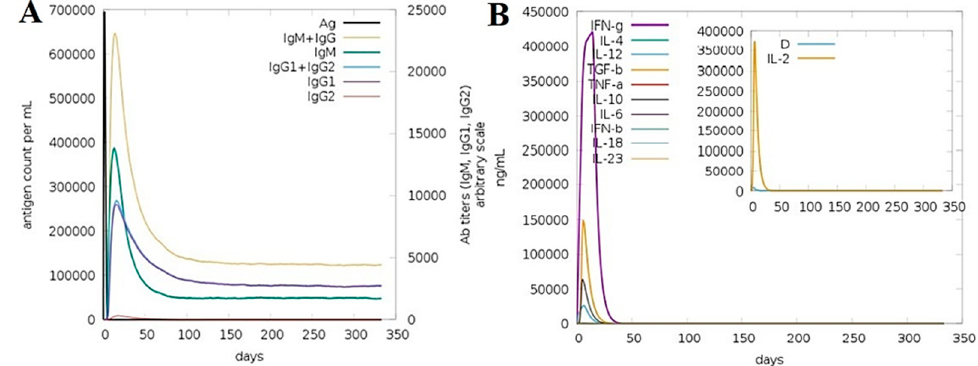
Figure 11. ( A ) Immunoglobulin titer as shown in different color peaks in response to the vaccine injection (black color peak). ( B ) Simulation of interleukins and the interferon level after the injection of vaccine.